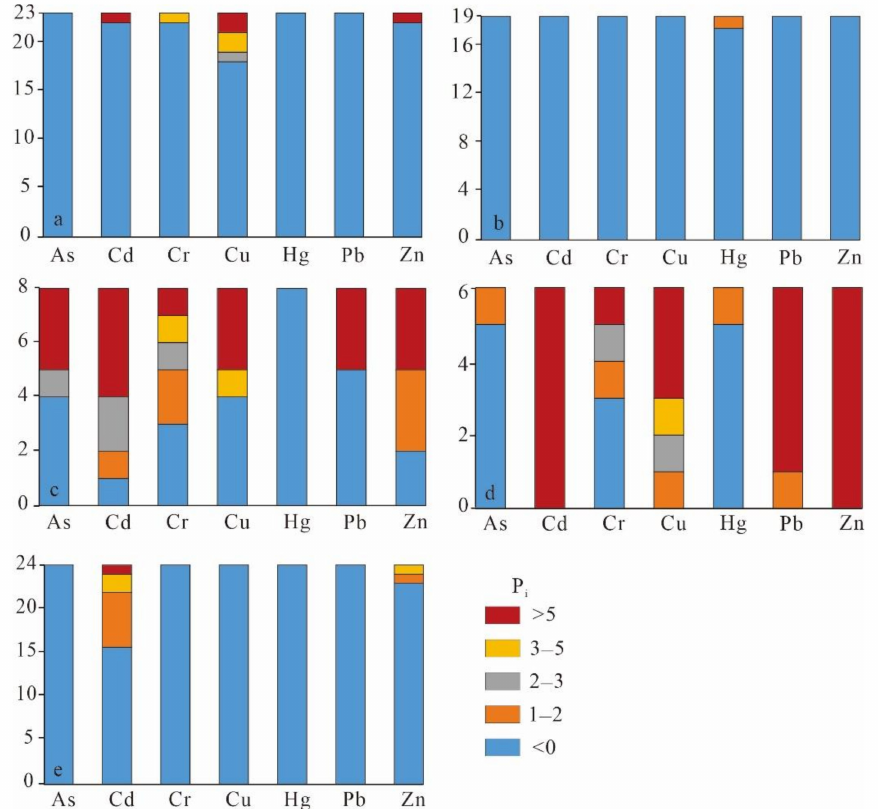
Figure 7. Number of P i levels for surface water samples in different streams: ( a ) Dawu tributary, ( b ) Le’an River, ( c ) Fujiawu tributary, ( d ) Yinshan tributary, and ( e ) Dexing